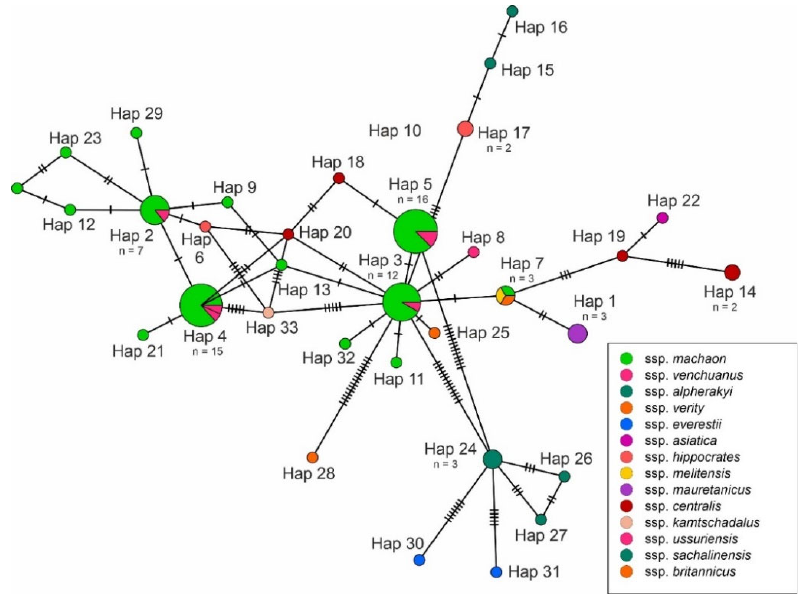
Figure 3. Median ‐ joining haplotype network for cytochrome b sequences. Different colours are re ‐ lated to subspecies, recognized according to Sturm [3]. The number of individuals with the same haplotype is provided below the haplotype name. Hatch marks along edges represent the number of mutations between nodes.